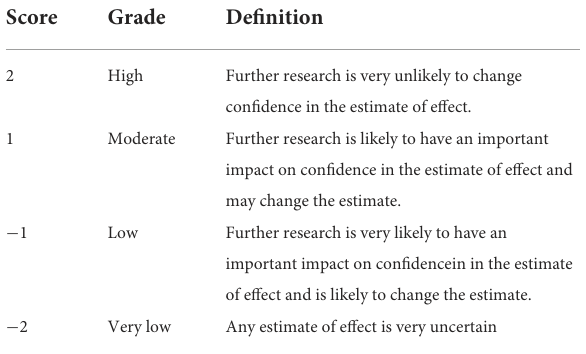
TABLE 1 Grade Recommendations Assessment, Development, and Evaluation (GRADE) system.